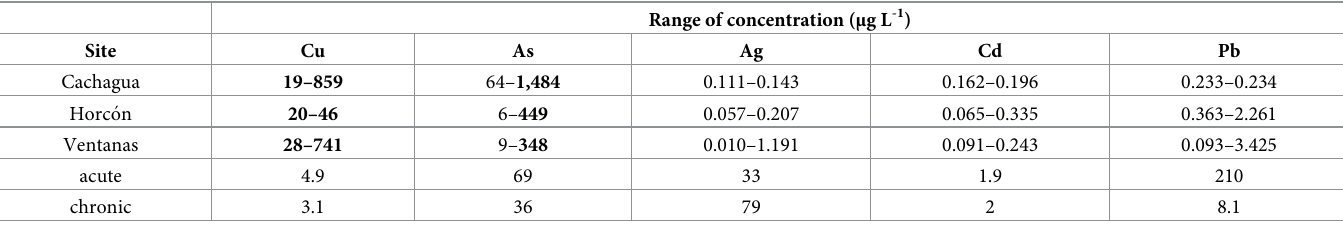
Table 1. Range of concentrations of heavy metals in seawater from Cachagua, Horco´n and Ventanas